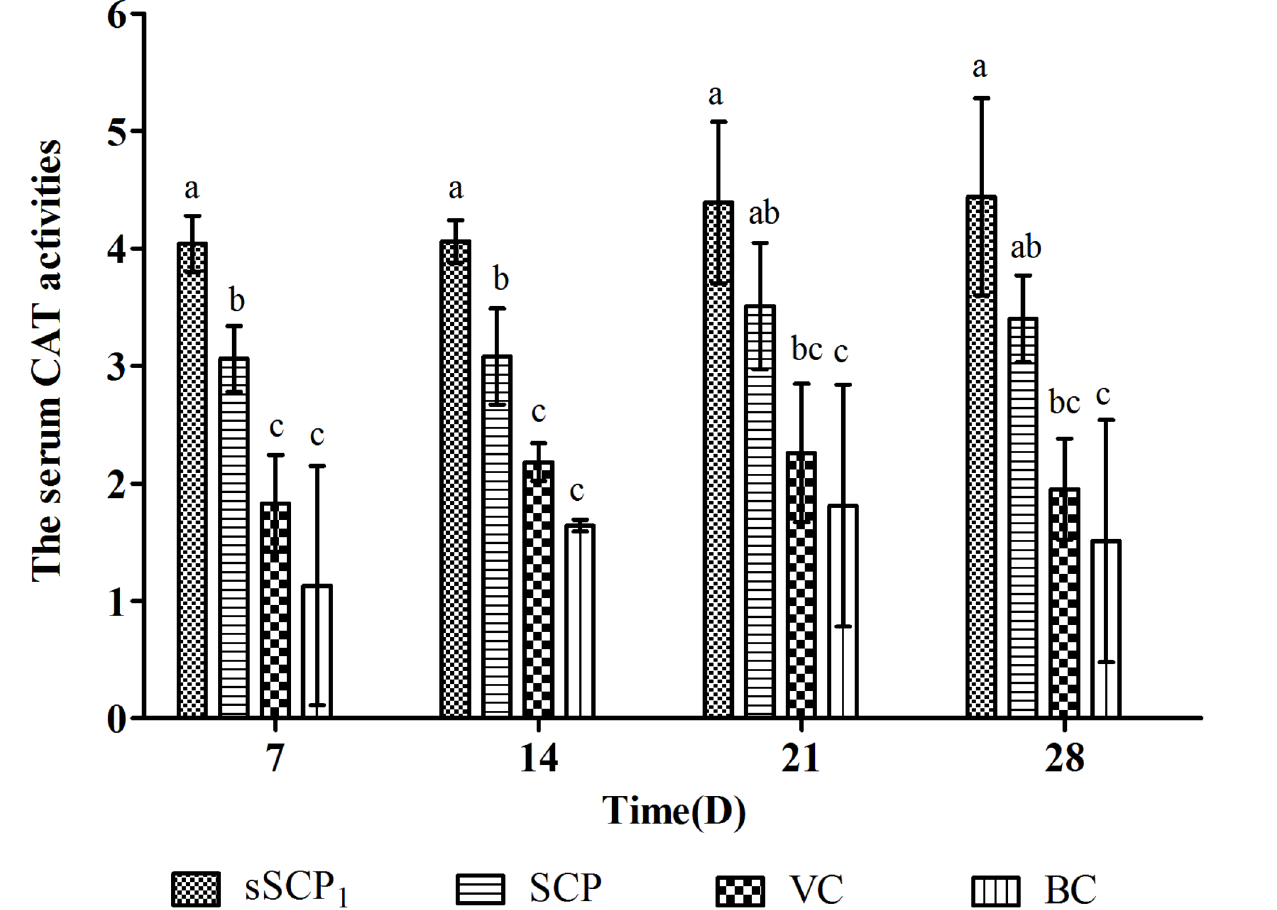
Fig 8. The serum CAT activities in each group. Bars in same time without the same superscripts (a – c) differ significantly ( P < 0.05).